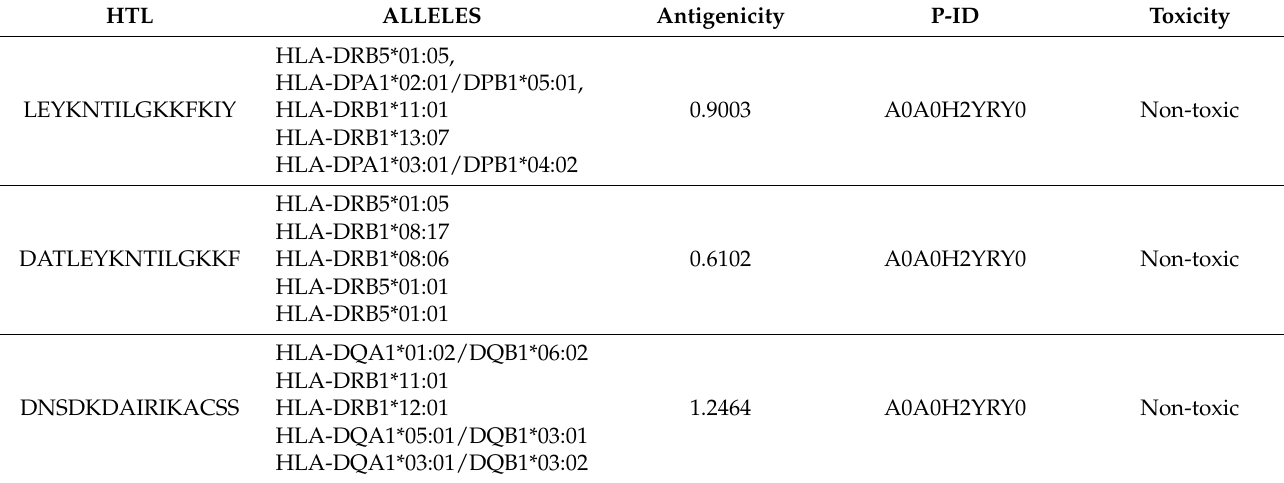
Table 2. HTL epitopes for MEV vaccine.